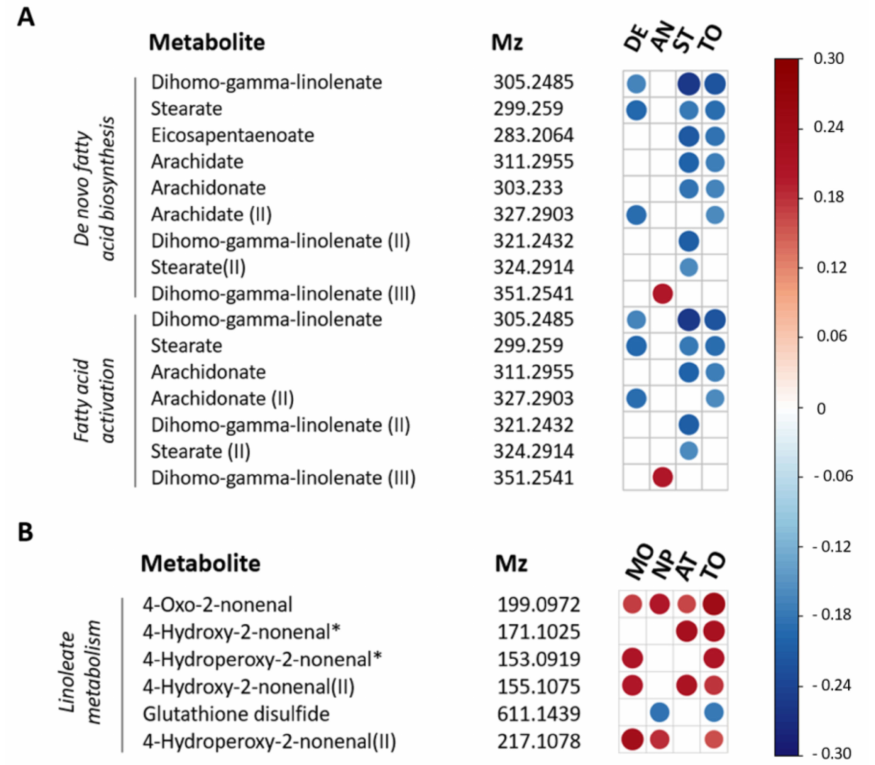
Figure 2. Spearman correlation plot for individual metabolites contributing to metabolic pathways associated with depression, anxiety and stress and impulsivity. ( A ) Metabolic features associated with DASS-42 scores involved in de novo fatty acid biosynthesis and fatty acid activation. ( B ) Metabolic features associated with BIS-11 scores and involved in linoleate metabolism. Strength and direction of the correlation coefficients are only shown for p < 0.05 (not FDR-corrected). The m / z values within each pathway are ordered based on p -values. m / z values referring to multiple significant pathways are depicted multiple times. II, III = multiple m / z values could be identified as the same metabolites. * = m / z value could be identified as multiple possible metabolites within a pathway, see Supplementary Figure S3 for all options. DE = depression, AN = anxiety, ST = stress, MO = motor impulsivity, NP = non planning impulsivity, AT = attentional impulsivity, TO = total DASS-42 ( A ) or BIS-11 score ( B